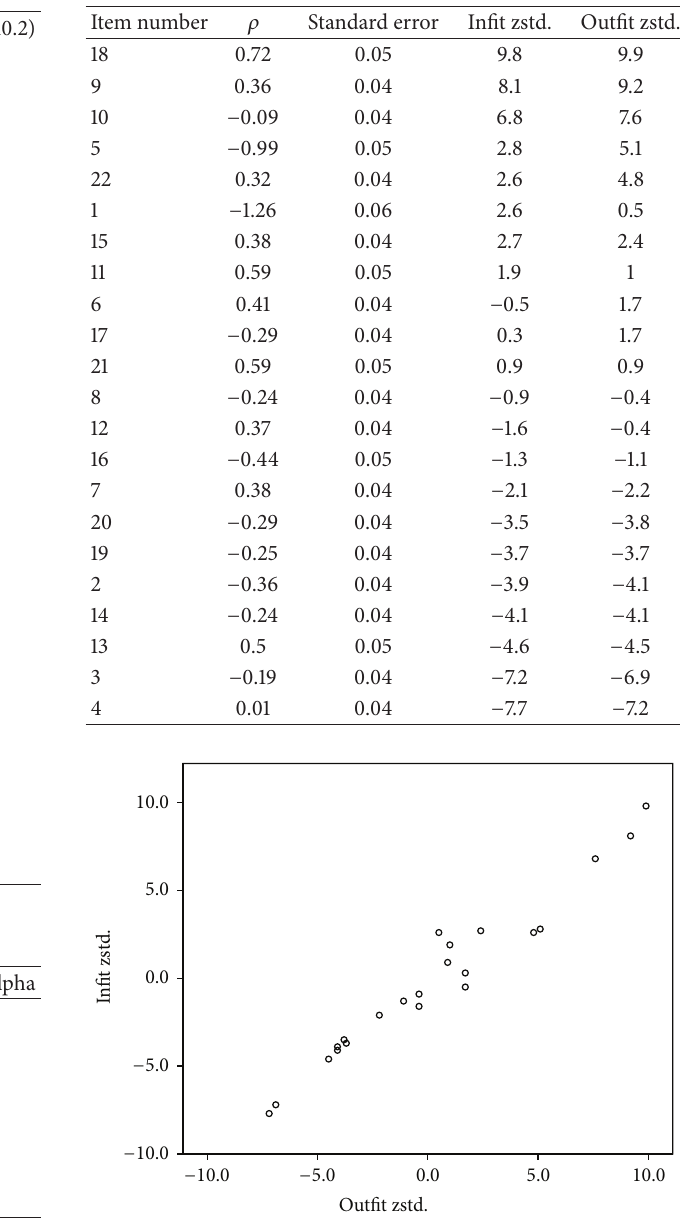
Table 1: Demographics.